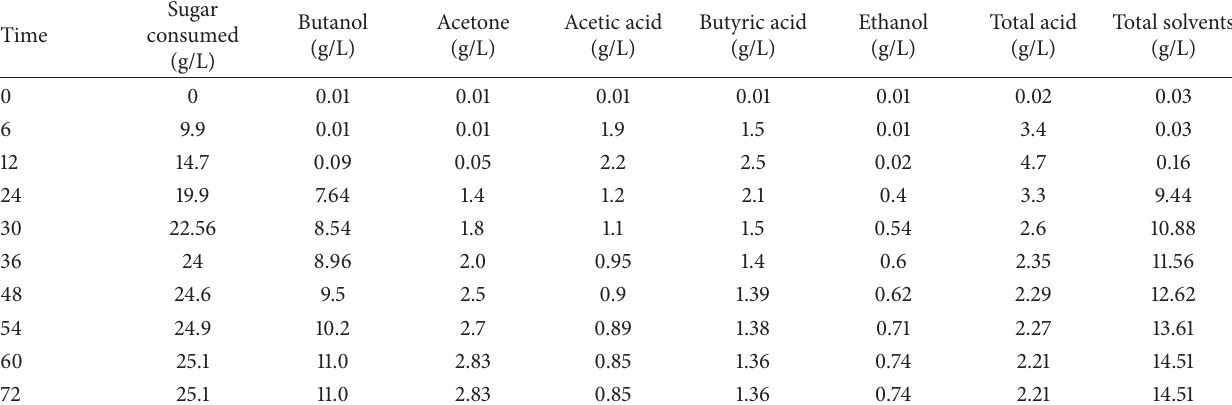
Table 5: Product formation by C. acetobutylicum NCIMB 13357 in ABE fermentation process using 50 g/L date fruit in P2